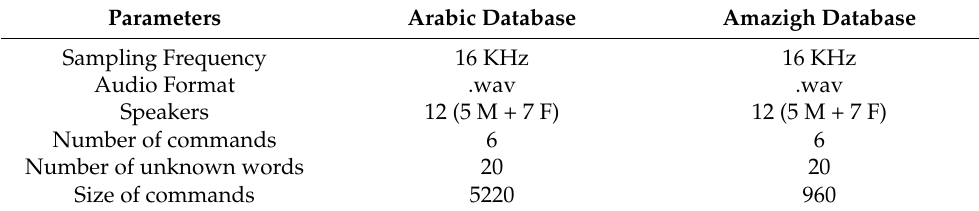
Table 1. Clips characteristics in Arabic and Amazigh databases